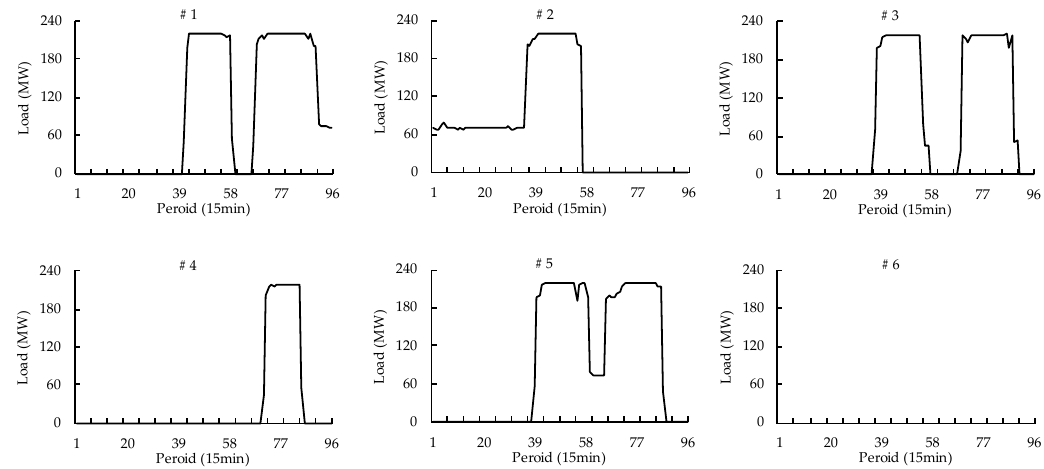
Figure 7. Load dispatch results of #1–#6 for dry season with low-rate load.